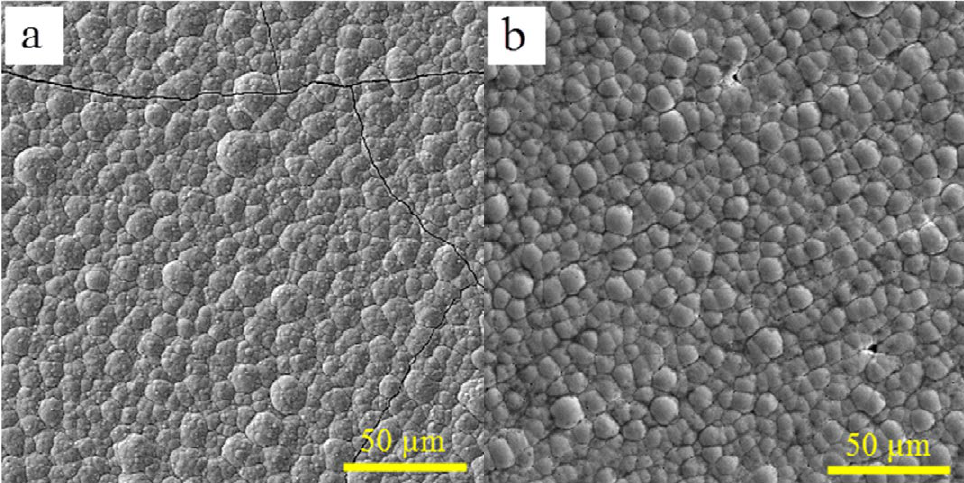
Fig. 2. SEM micrographs from surface of the as-deposited (a) Co-Cr and (b) Co-Cr/TiO 2 coatings.